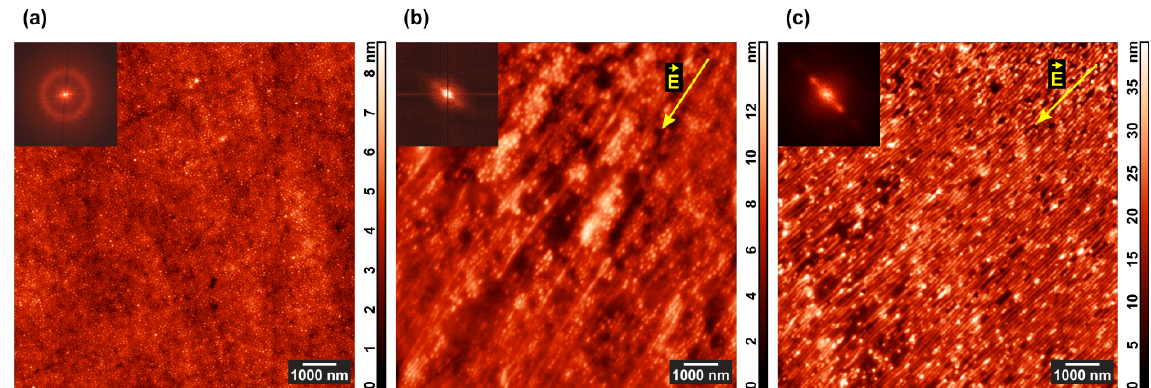
Figure 3. AFM images of the most-ordered areas in ( a ) PS–P4VP/AuNR film annealed under chloroform vapor; ( b ) PS–P4VP film annealed under chloroform vapor and DC field; ( c ) PS–P4VP/AuNR film annealed under chloroform vapor and DC field. 2D Fourier transforms of the corresponding topographies are shown in the insets.